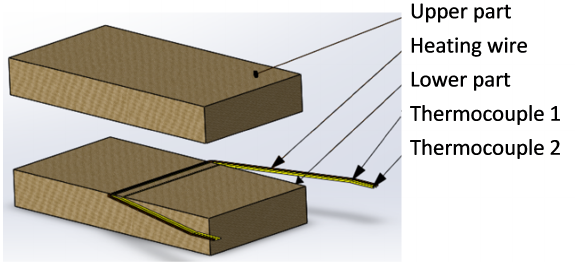
Figure 1. The sample arrangement when determining the thermal conductivity λ and thermal capacity c by the Hot wire